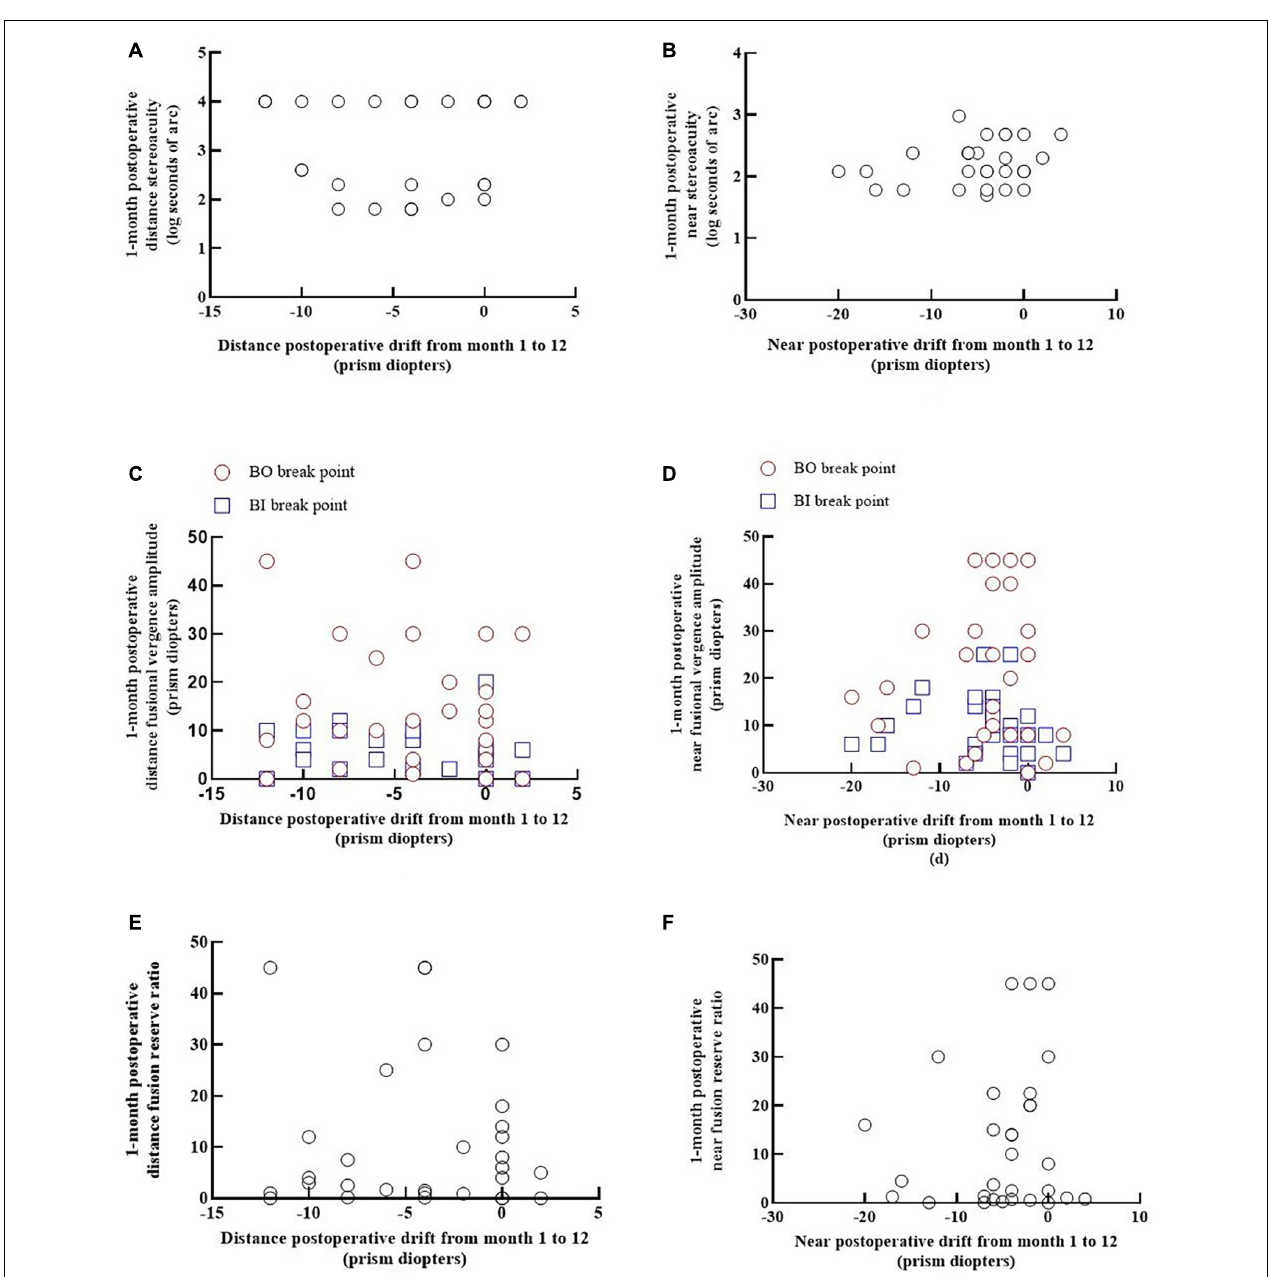
FIGURE 2 | Relationships between postoperative binocular functions and postoperative drift at distance and near fixations. Each panel shows the data from 30 patients. The positive values indicate esodrift, and the negative values indicate exodrift. (A,B) Show the relationship between 1-month postoperative stereoacuity and the postoperative drift from months 1 to 12 for distance and near fixations [ r s = 0.106 ( p = 0.579) and r s = 0.143 ( p = 0.450), respectively]. (C,D) Show the relationship between the convergence and divergence amplitude and postoperative drift at distance fixation (BO: r s = -0.115, p = 0.546; BI: r s = -0.336, p = 0.075) and at near fixation (BO: r s = 0.031, p = 0.870; BI: r s = -0.268, p = 0.159). (E,F) Show that the relationships between the 1-month postoperative fusion reserve ratio and postoperative drift from months 1 to 12 were not significant for distance or near fixation [ r s = 0.003 ( p = 0.987) and r s = 0.110 ( p = 0.564),